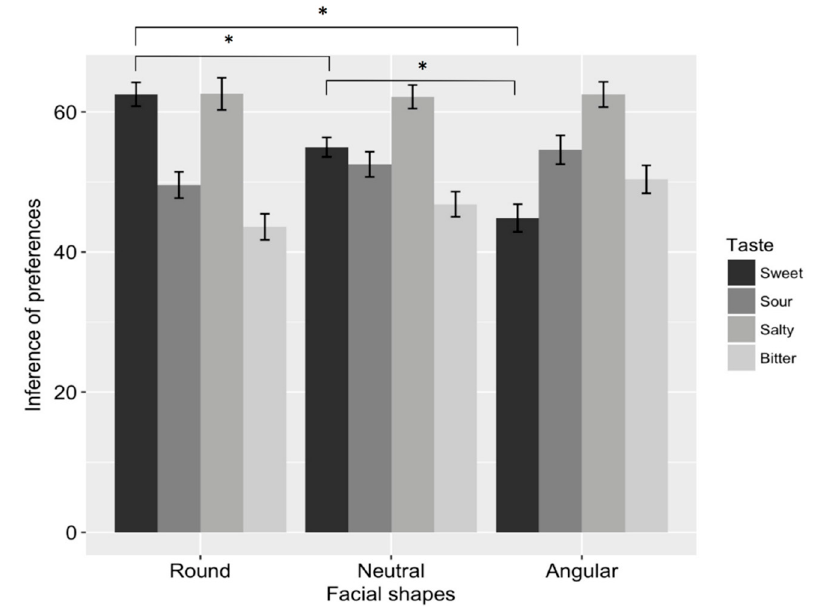
Figure 6. Results of Study 3. Round-faced (vs. angular- and neutral-faced) individuals were perceived as more strongly preferring sweet foods. Angular-faced (vs. round- and neutral-faced) individuals were perceived as more strongly preferring bitter foods. Angular-faced (vs. round-faced) individuals were perceived as more strongly preferring sour foods. Asterisks indicate significant paths ( p < 0.05 *). Error bars represent standard error.